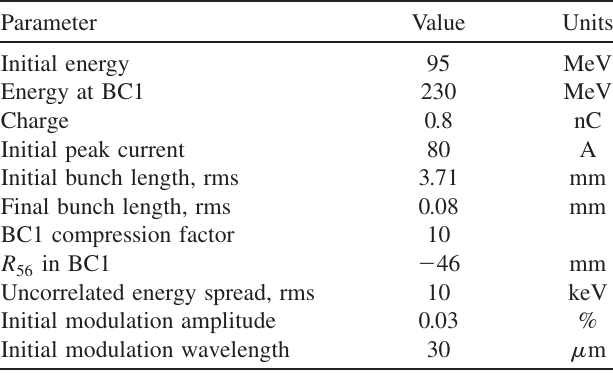
TABLE IV. FERMI@elettra electron beam parameters.